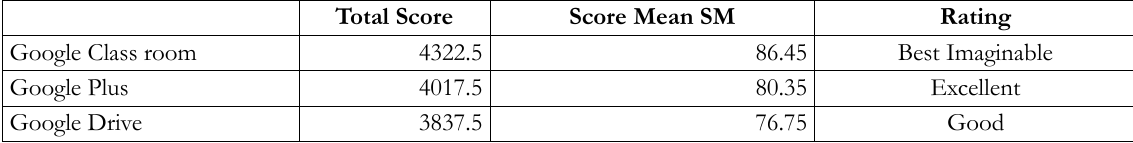
Table 4. SUS rating for each